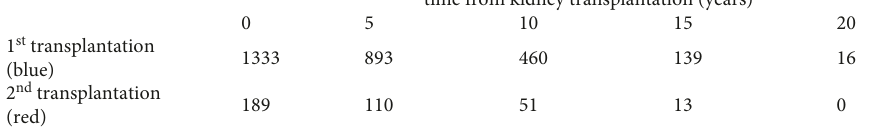
Figure 1: Graft survival. Table 4: Likelihood of